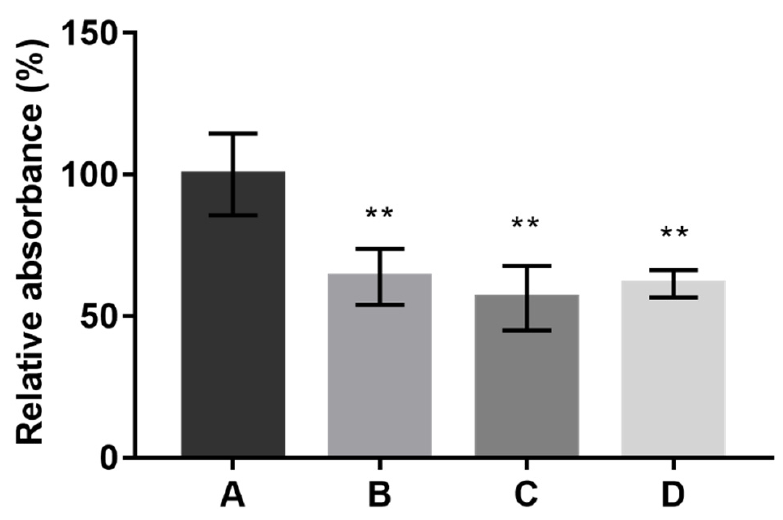
Figure 5. Relative absorbance (%) obtained from the sum of the absorbance values at the three wavelengths (400, 470, and 500 nm) after 12 days of fermentation under solid-state fermentation using an inert support, and culture media A, B, C, and D. Values are the mean ± SD ( n = 3). Statistical analysis was performed by one-way ANOVA (** p < 0.01).